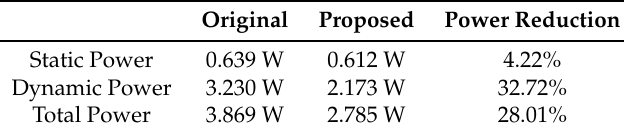
Figure 13. Power consumption comparison of the CNN accelerator on FPGA. Table 1. Power consumption comparison of the CNN accelerator on FPGA.